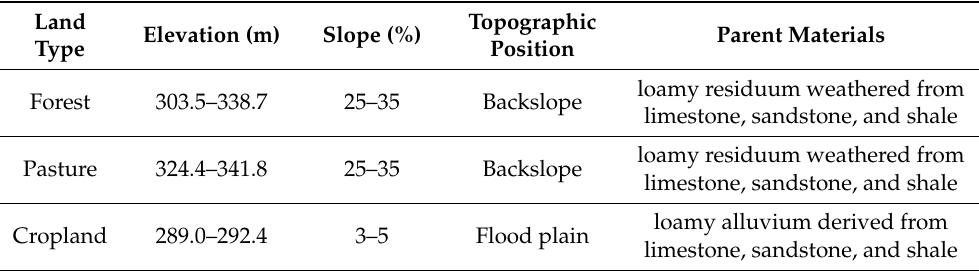
Table 1. The characteristics of the sampling plots in hardwood forest (HF), cropland with manure (CM) and continuous pasture